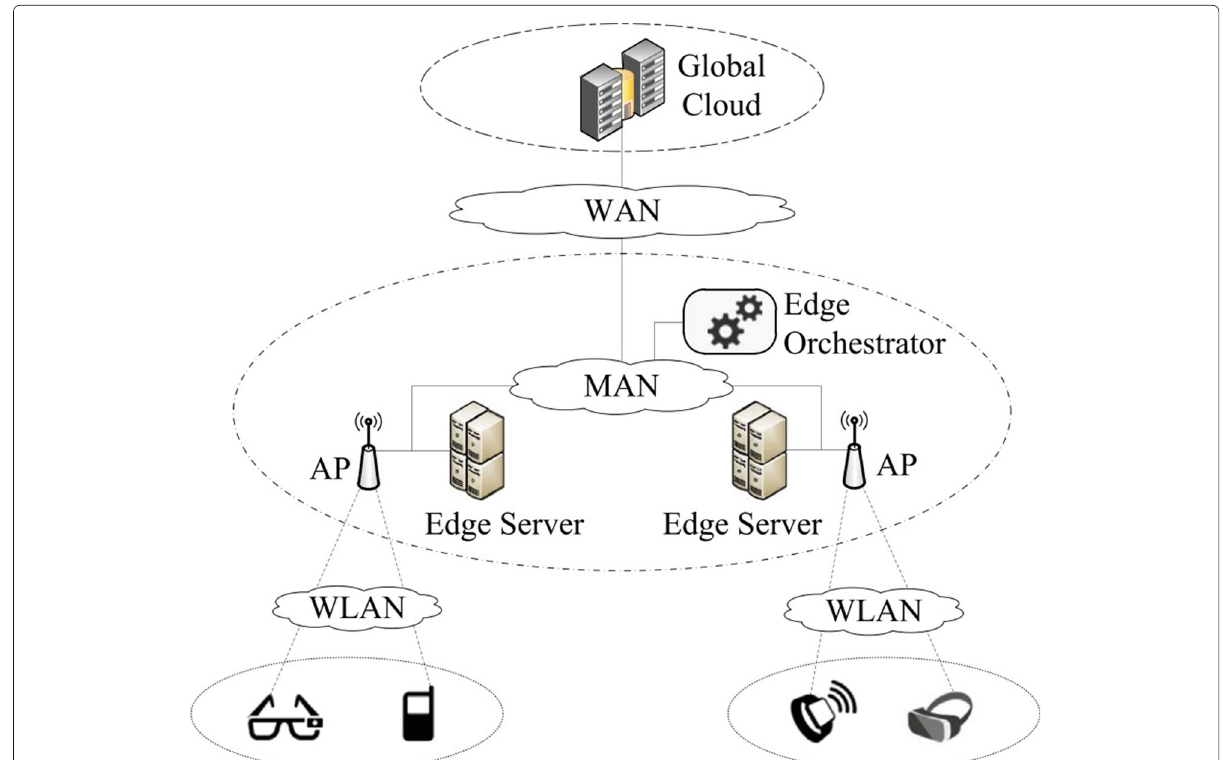
Fig. 1 Multi-tier edge computing architecture with edge